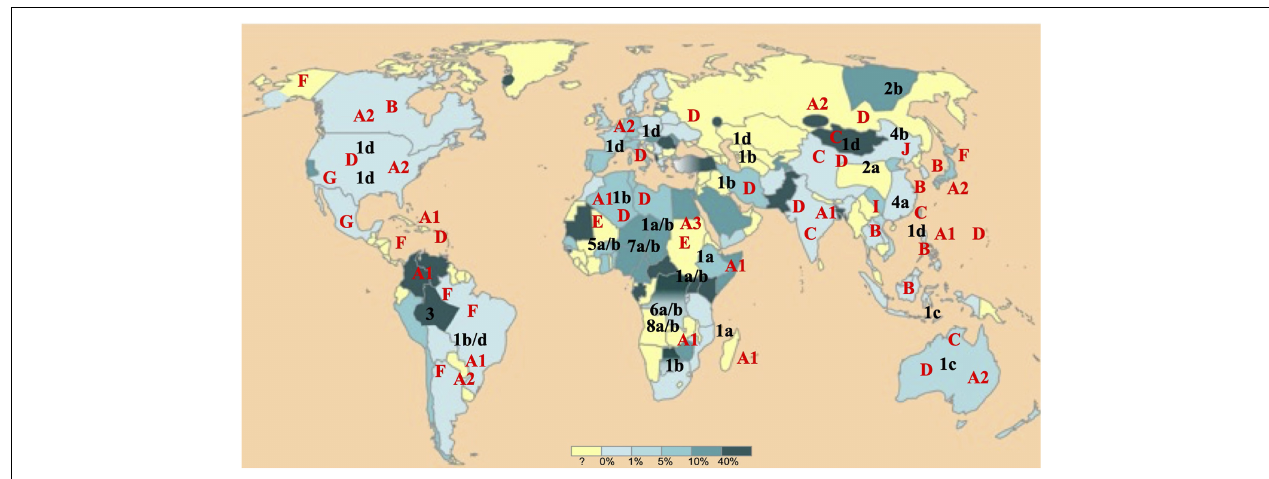
FIGURE 1 | Worldwide hepatitis B virus (HBV) and Hepatitis Delta Virus (HDV) (sub)genotypes distribution. HBV and HDV (sub)genotypes are denoted, respectively in red and in black. The world map is colored according to a gradient of total anti-HDV antibody prevalence to up to 40% drawn from almost all most international publications (adapted from EMC – Biologie médicale 2018;13(3):1–9).